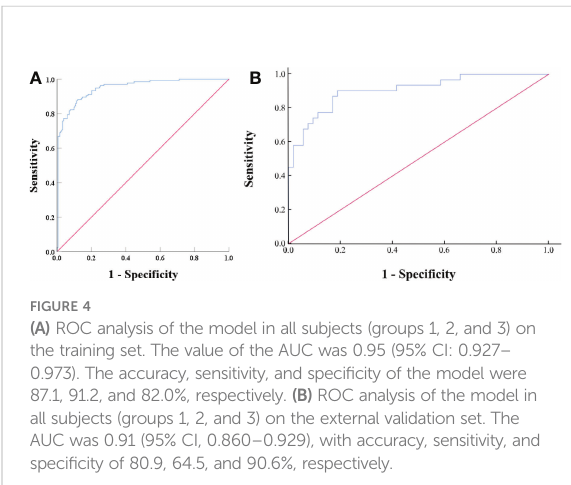
FIGURE 4 (A) ROC analysis of the model in all subjects (groups 1, 2, and 3) on the training set. The value of the AUC was 0.95 (95% CI: 0.927 – 0.973). The accuracy, sensitivity, and speci fi city of the model were 87.1, 91.2, and 82.0%, respectively. (B) ROC analysis of the model in all subjects (groups 1, 2, and 3) on the external validation set. The AUC was 0.91 (95% CI, 0.860 – 0.929), with accuracy, sensitivity, and speci fi city of 80.9, 64.5, and 90.6%, respectively.